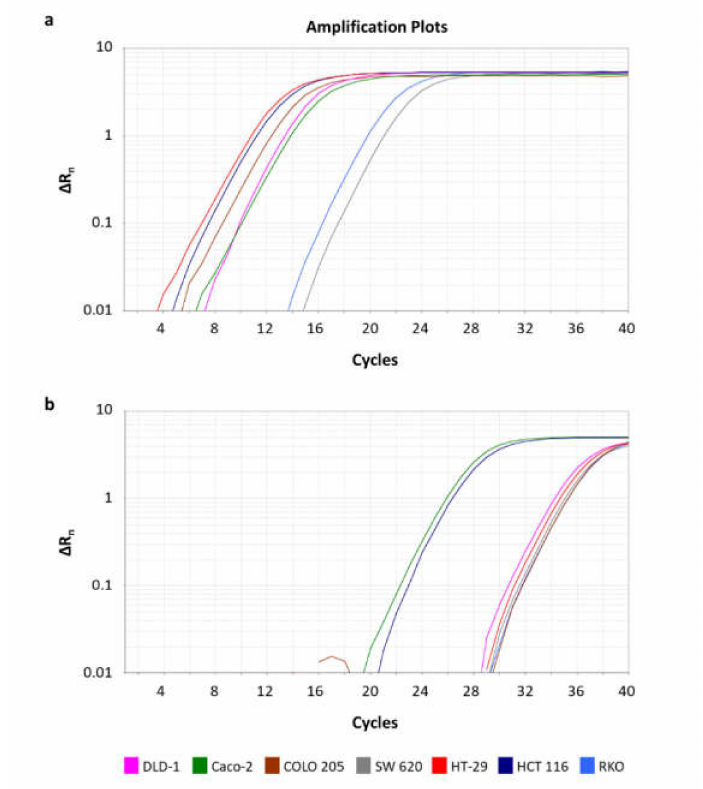
Figure 3. Amplification plots of circ-BCL2L12-1 ( a ) and circ-BCL2L12-2 ( b ) in colorectal cancer (CRC) cell lines.